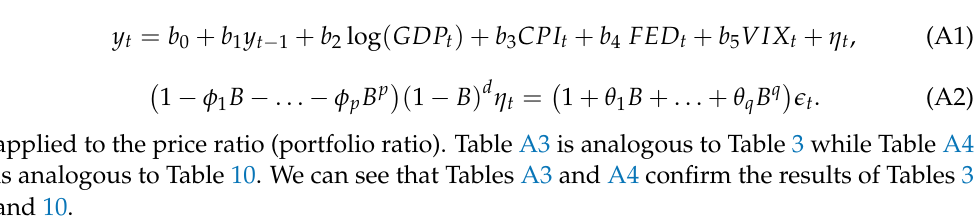
Table A3. Results of model (A1)–(A2) on smart beta. Panel A includes data from January 2014 to May 2019, Panel B from